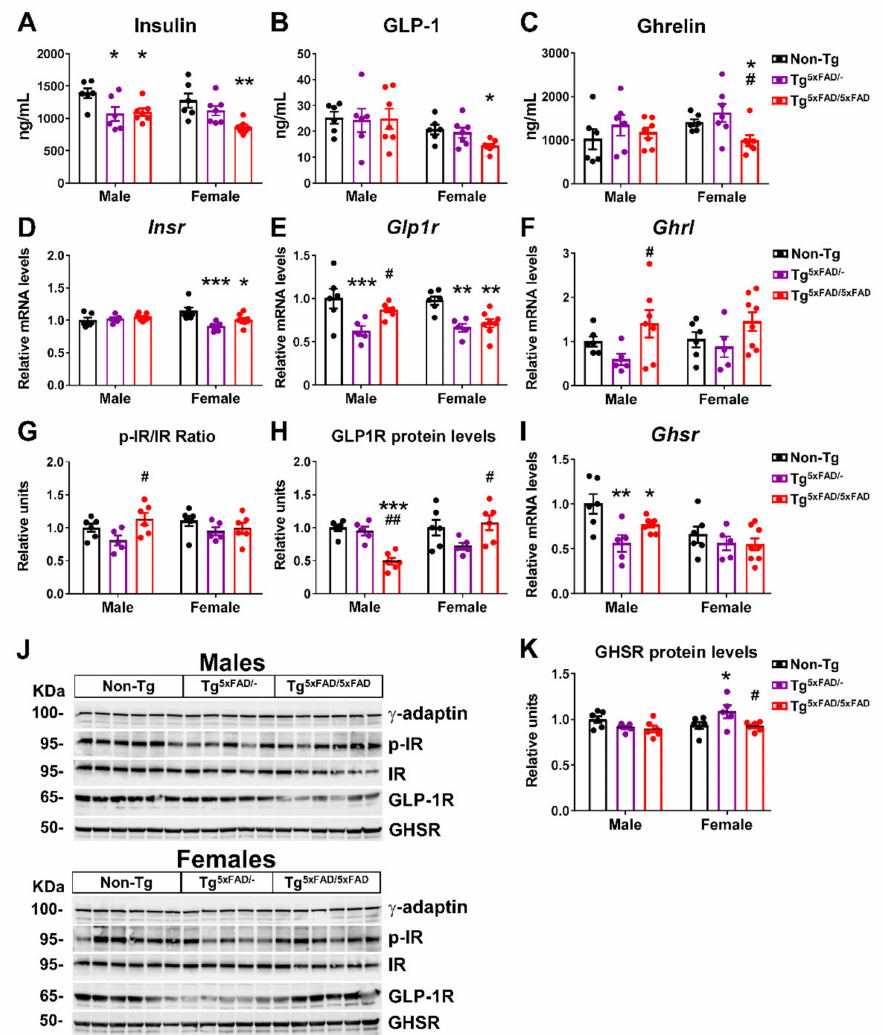
Figure 4. Altered insulin, leptin, and GLP-1 plasma levels and hypothalamic receptors were genotype and sex-specific in 5xFAD mice at 6 months of age. ( A – C ) Plasma levels of insulin, leptin, and GLP-1 ( n = 6–7 per group). ( D – F ) Representative quantification of expression of insulin receptor ( Insr ), leptin receptor ( Lepr ), and GLP-1 receptor ( Glp1r ) in hypothalamus assessed by qPCR ( n = 5–8 per group). ( G – I ) Representation of Western blot membranes, and ( J ) densitometric evaluation of insulin receptor (IR) activation (p-IR/IR), leptin receptor (LepR) activation (p-LepR/LepR), and GLP-1 receptor (GLP1R) protein levels ( n = 5–6 per group). Protein levels were normalized with γ -adaptin. Associ- ated phosphorylations were normalized with respective total protein levels. Non-Tg males were set as 1 for relative mRNA units and protein relative units. Two-way ANOVA analysis with Tukey’s post hoc test: * = p < 0.05, ** = p < 0.01, *** = p < 0.001 versus same-sex non-Tg group; # = p < 0.05, ## = p < 0.01 versus same-sex Tg 5xFAD/-